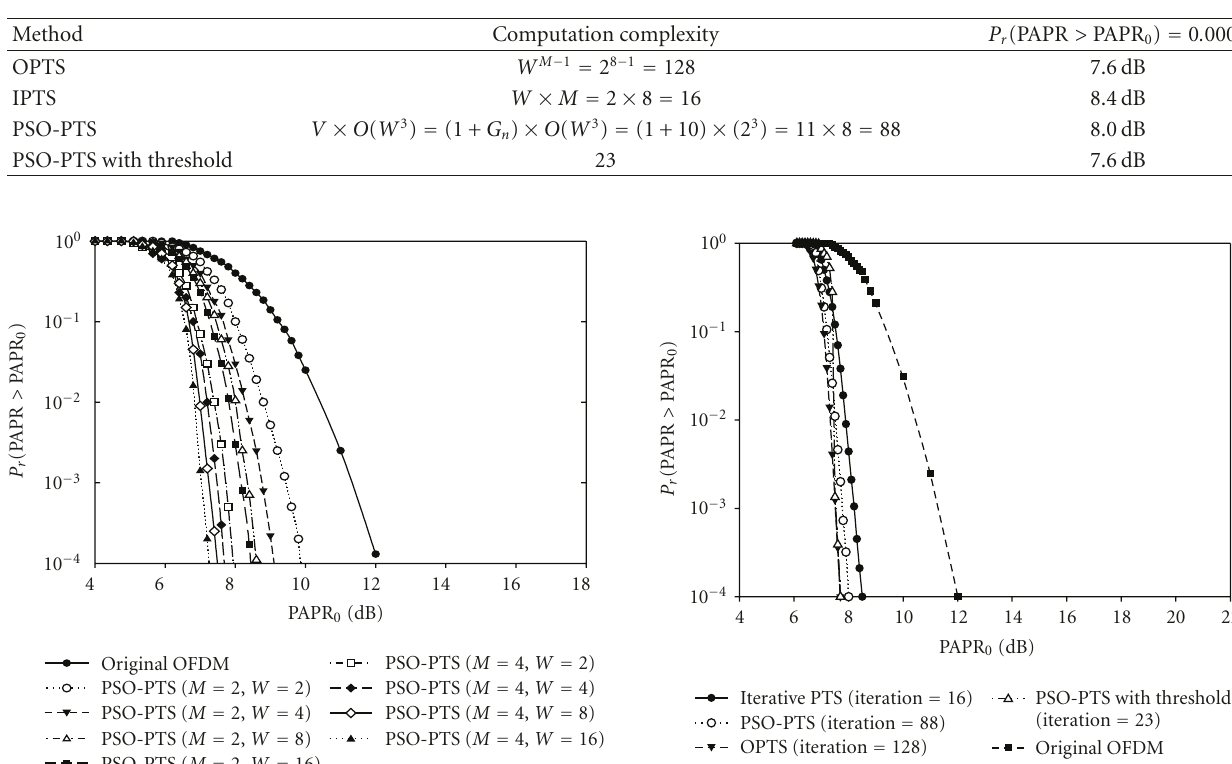
Table 1: The computational complexity of the OPTS, IPTS and PSO-PTS techniques with phase weighting factor W = 2.